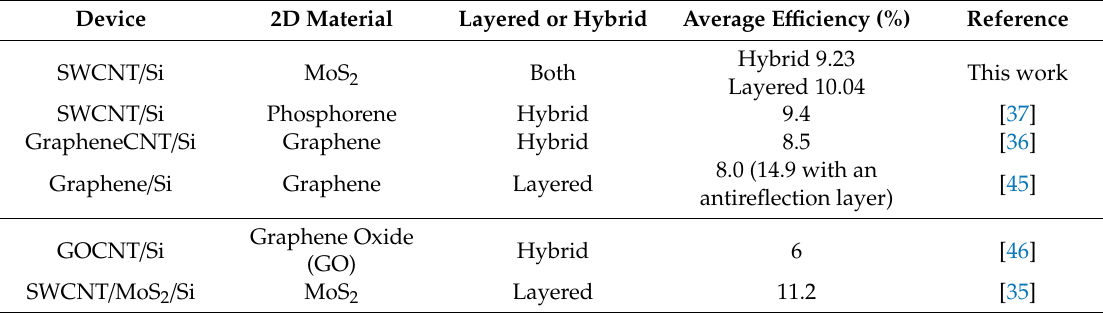
Table 1. Device e ffi ciencies for various carbon nanotube / silicon (CNT / Si) devices produced using 2D